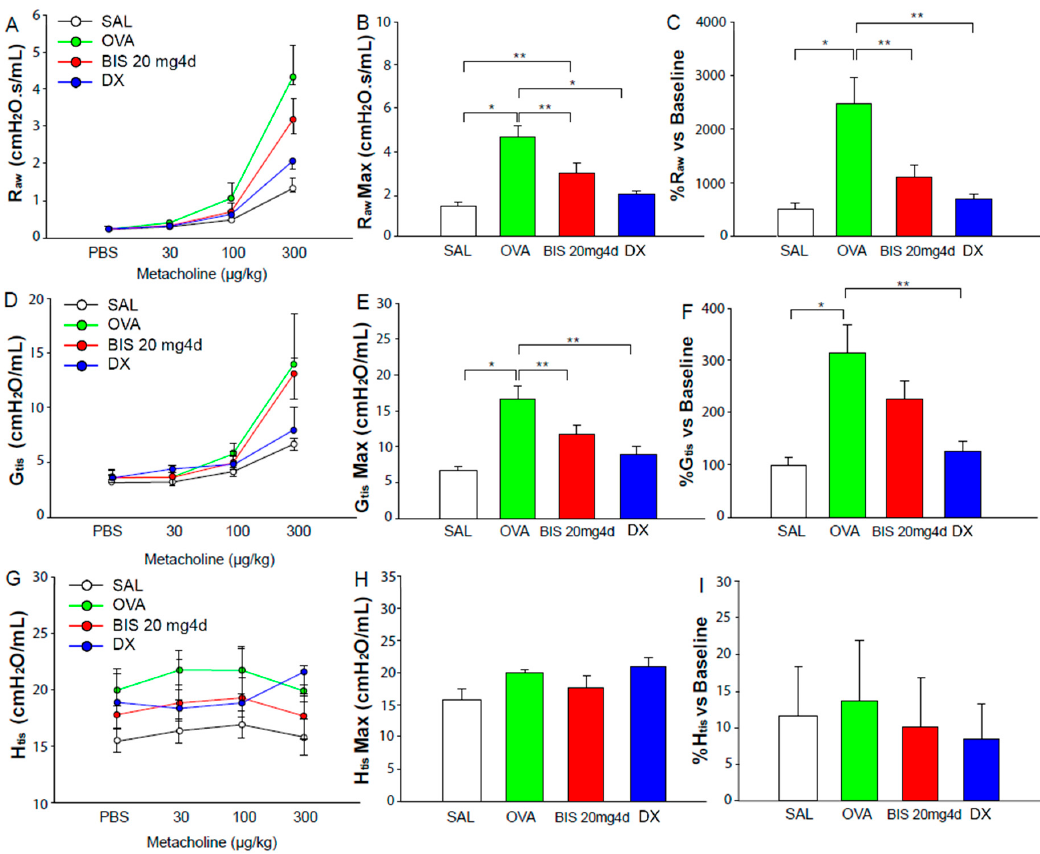
Figure 3. Lung function parameters. ( A ): Dose response curve of R aw (Airway resistance); ( B ): Maximal response of R aw ; ( C ): % of R aw in relation to baseline values; ( D ): Dose response curve of G tis (tissue resistance); ( E ): Maximal response of G tis ; ( F ): % of G tis in relation to baseline values; ( G ): Dose response curve of H tis (tissue elastance); ( H ): Maximal response of H tis ; ( I ): % of H tis in relation to baseline values. SAL ( n = 8): saline control group; OVA ( n = 9): ovalbumin-sensitized control group; BIS ( n = 6): ovalbumin-sensitized group treated with biseugenol 20 mg · kg − 1 for 4 days; DX ( n = 7): ovalbumin-sensitized group treated with dexamethasone 5 mg · kg − 1 i.p. or 4 days. *: p < 0.001; **: p <